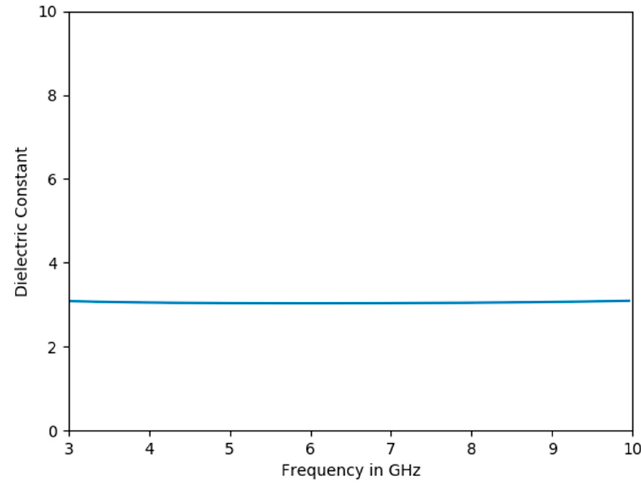
Figure 4. Rectangular Window applied for reflected signals of VWC of − 1.5%.